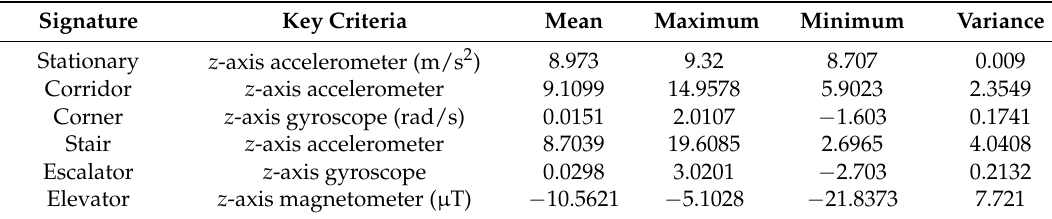
Table 2. Central values for landmark confirming